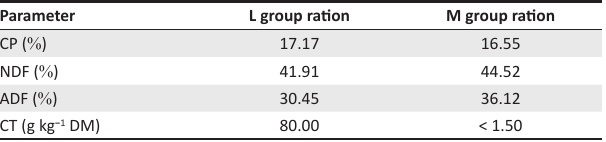
TABLE 1: Crude protein, fibre (neutral detergent fibre and acid detergent fibre) and condensed tannin levels of the rations fed to sheep.